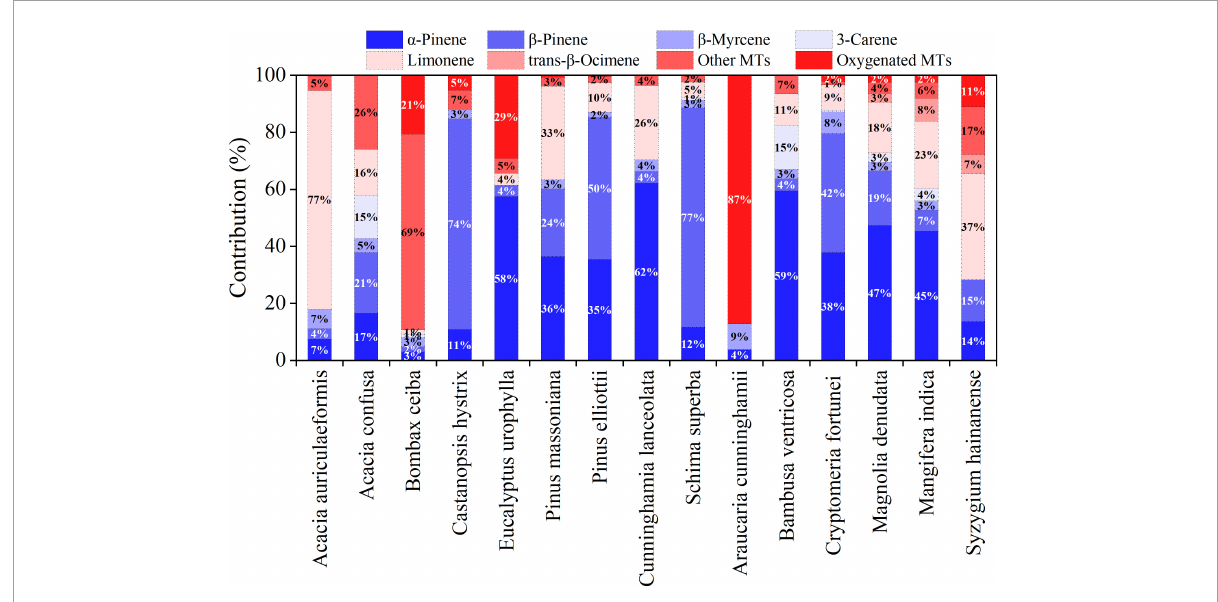
FIGURE3 Compositions of different monoterpenes (MTs) emitted from measured trees.